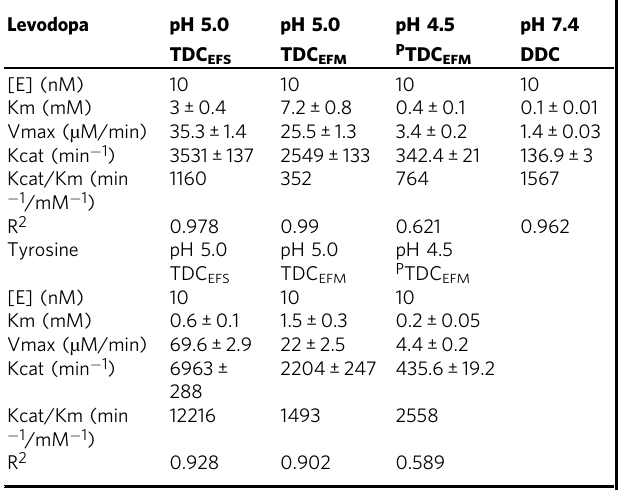
Table 1 Michaelis – Menten kinetic parameters